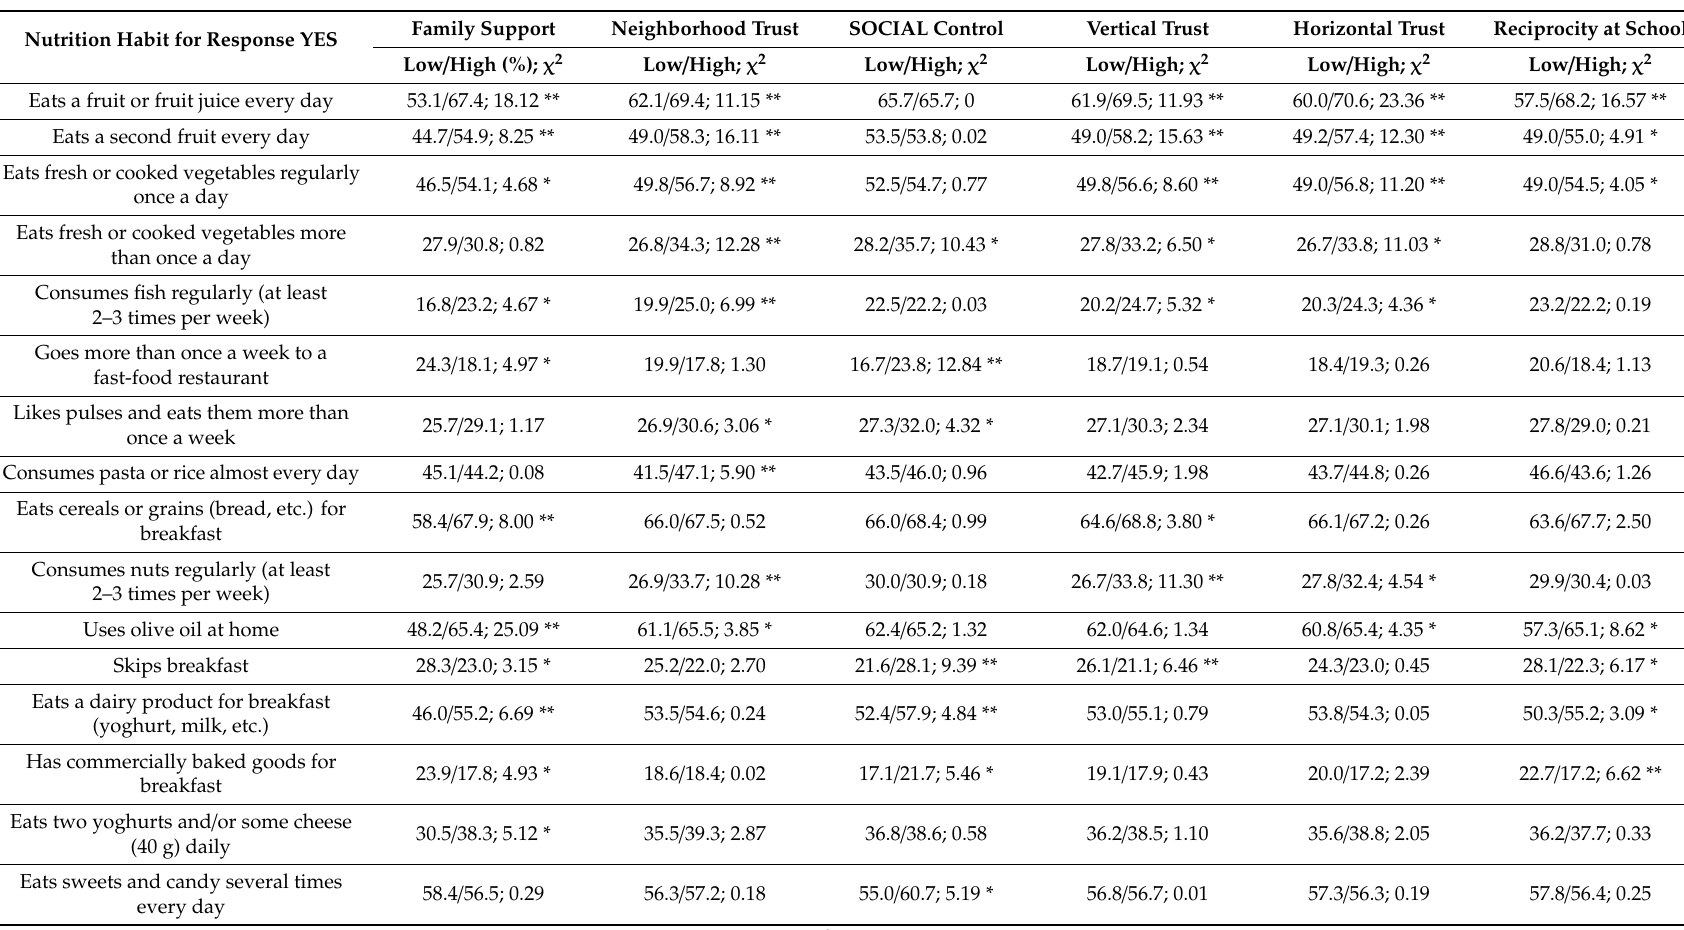
Table 3. Comparison of percentage distribution of nutrition habits among Lithuanian high school students with low and high social capital (chi-square test). Nutrition Habit for Response